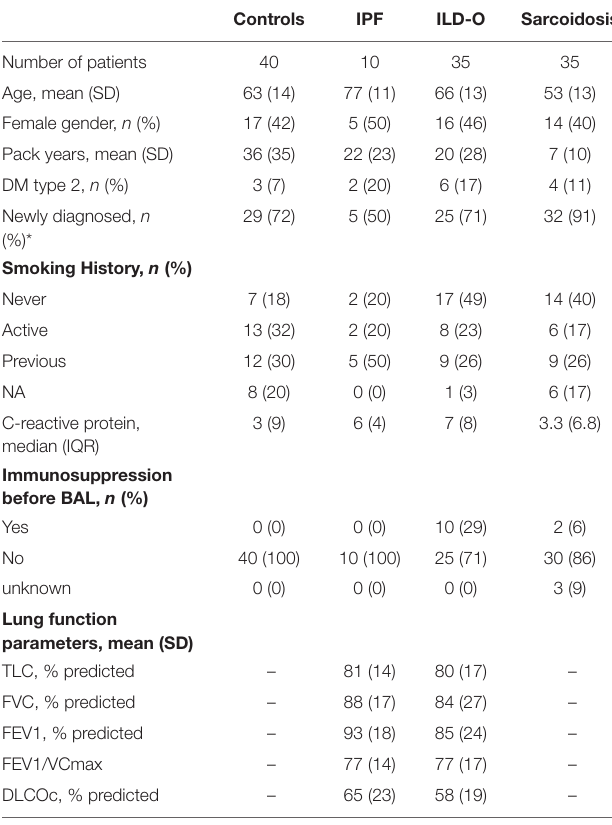
TABLE 1 | Baseline characteristics of cases and controls.